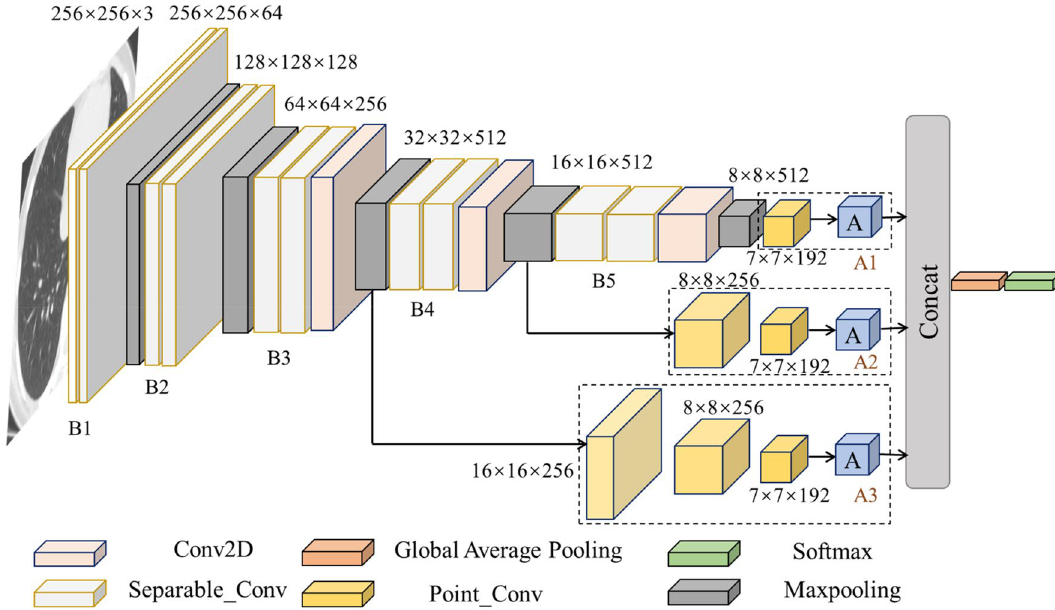
Figure 1. MGMADS-3 model for COVID-19 detection.